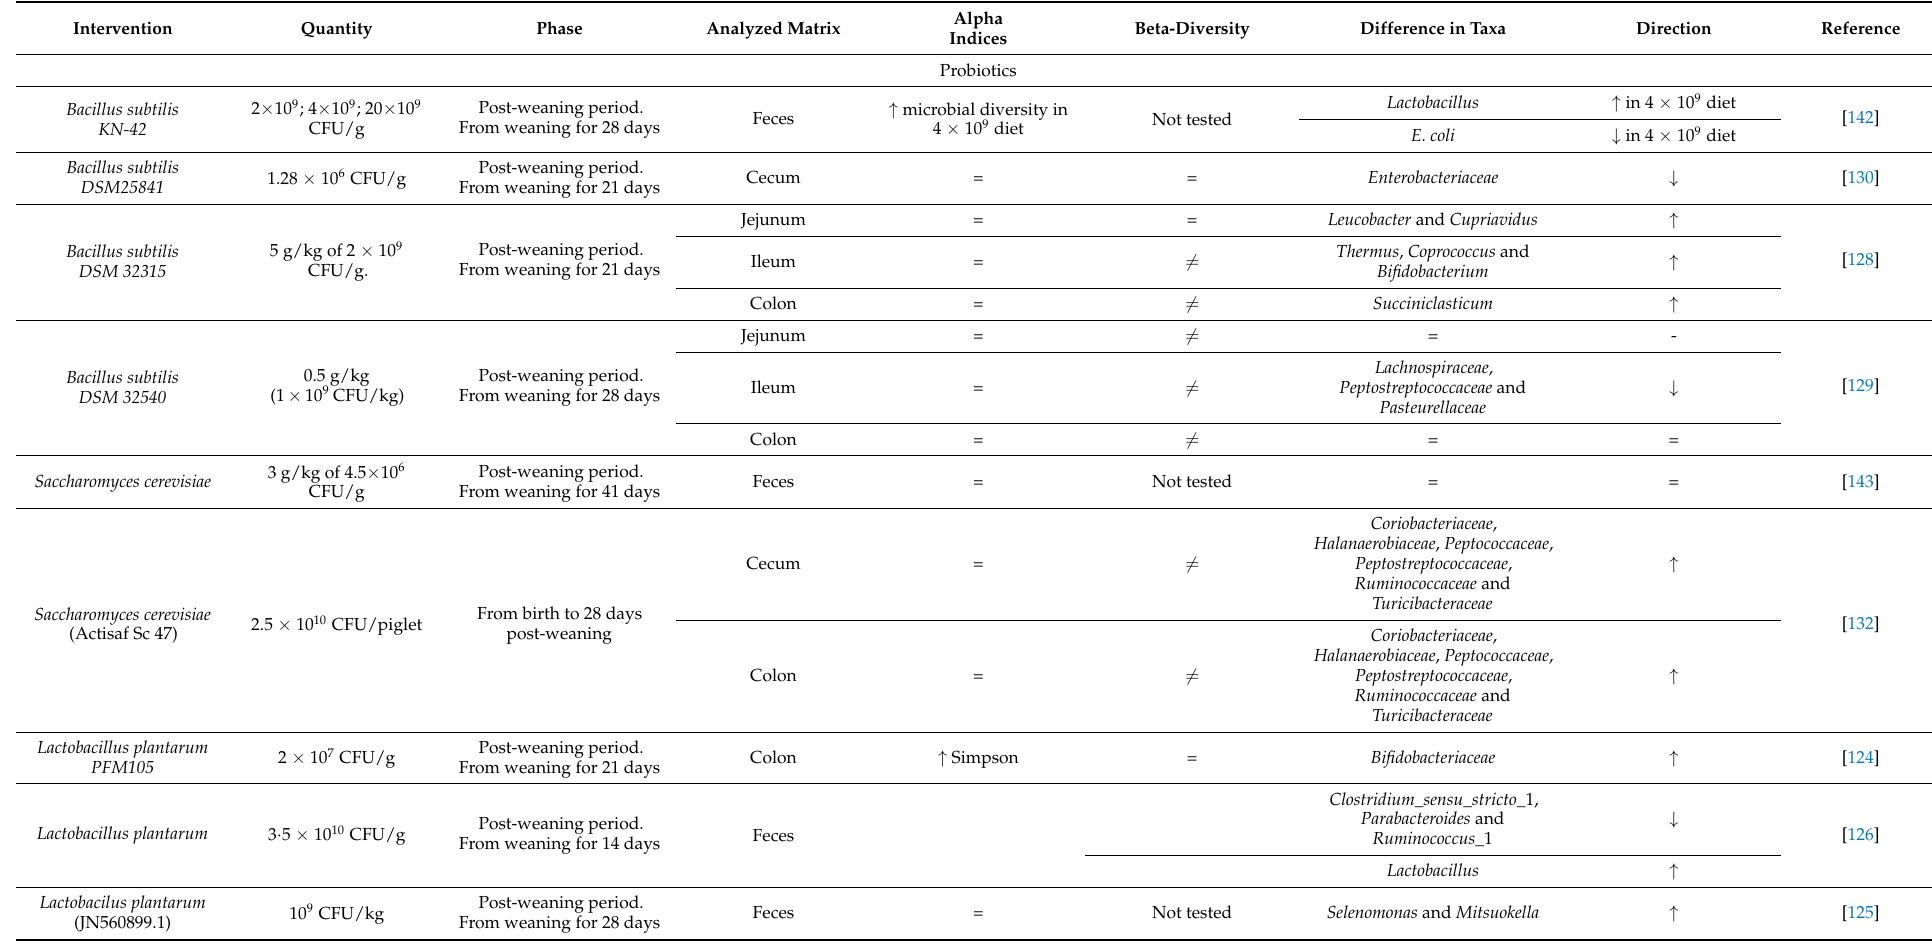
Table 1. Summary of the effects of probiotics and organic acid on the pig microbiota of post-weaning